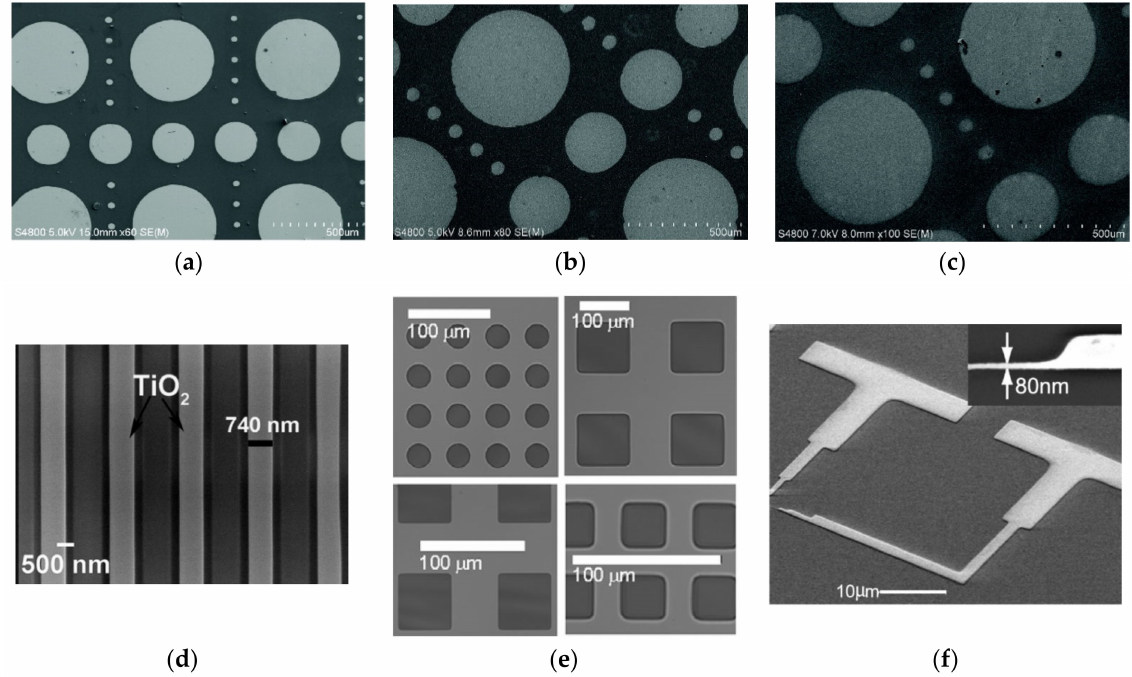
Figure 19. SEM micrographs of patterns produced on PMMA by AS-ALD tool for ( a ) Pt ( b ) Ir ( c ) Ru (adapted from [81], Copyright (2008), with permission from Elsevier); ( d ) TiO 2 (adapted with permission of Ali Haider, from [97]; permission conveyed through Copyright Clearance Center, Inc.); ( e ) TiO 2 , (republished with permission of (Ashwini Sinha), from [91]; permission conveyed through Copyright Clearance Center, Inc.); ( f ) HfO 2 , (reprinted from [99] with the permission of AIP Publishing) coatings in a silicon